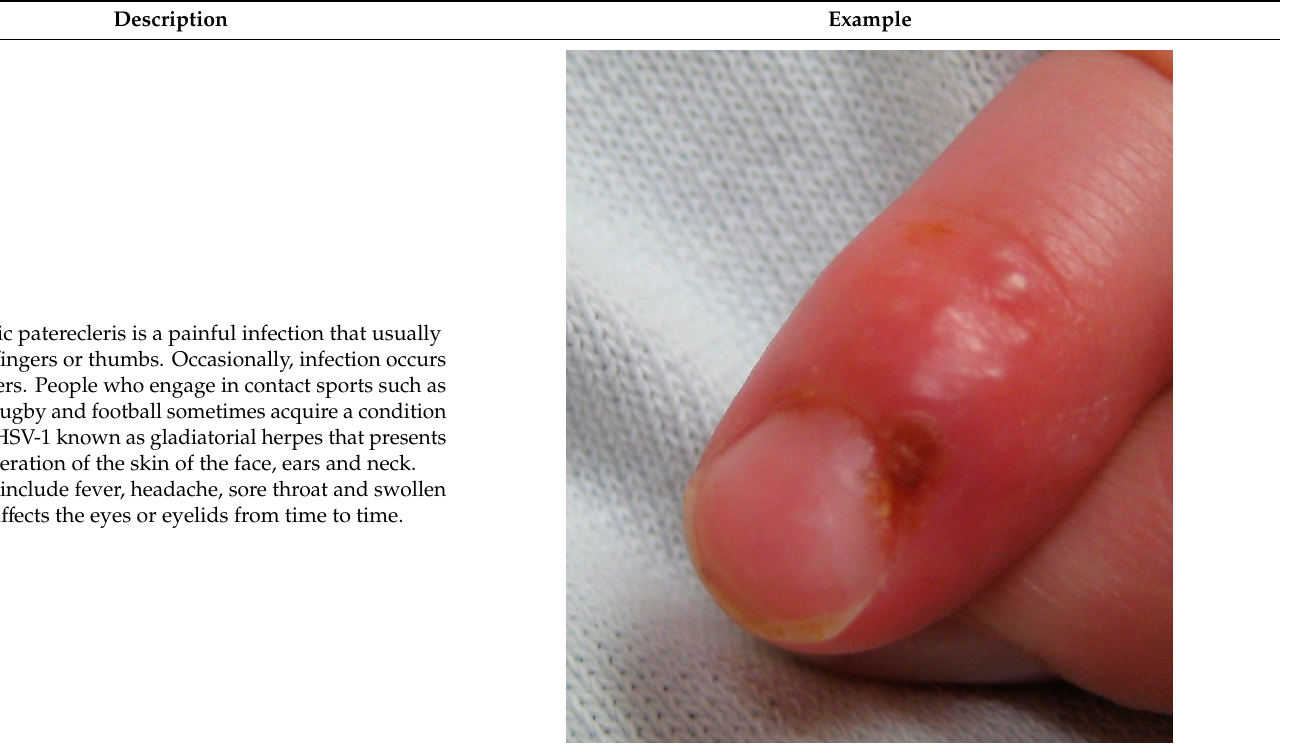
Figure 4. Herpetic paterecleris, licence CC BY SA 3.0, adapted for gentle concession of James Heilman, MD .